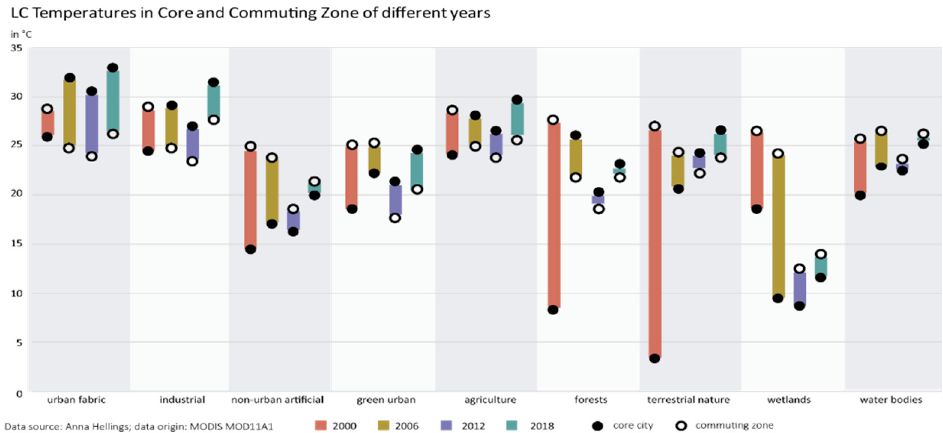
Figure 14. LST of different land covers in core and commuting zone of different years.